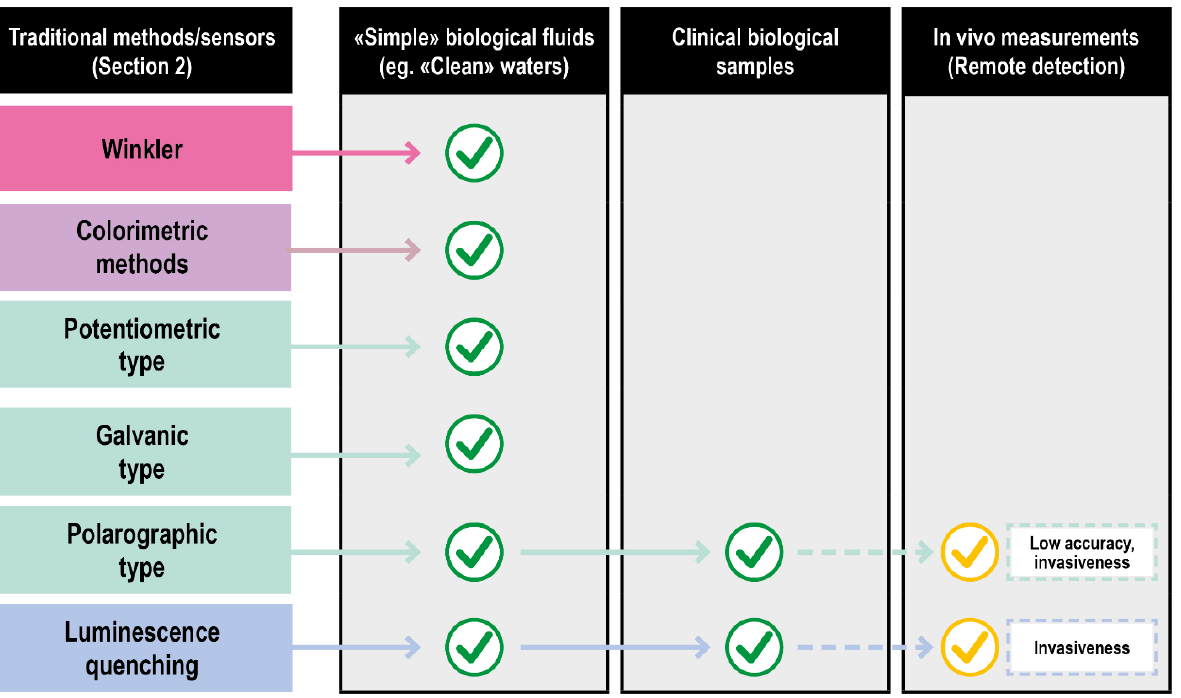
Figure 6 . Translation of DO sensing methods from classical to clinical settings of increasing com- plexity.